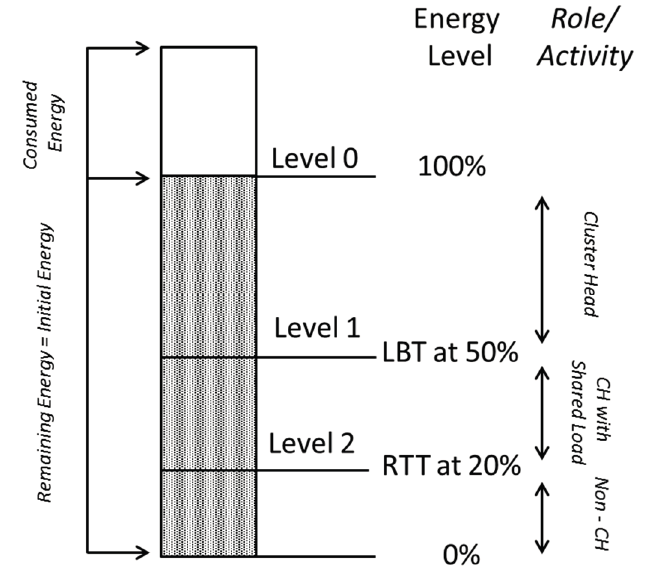
Figure 2. Switching of a CH to different roles based on its energy threshold